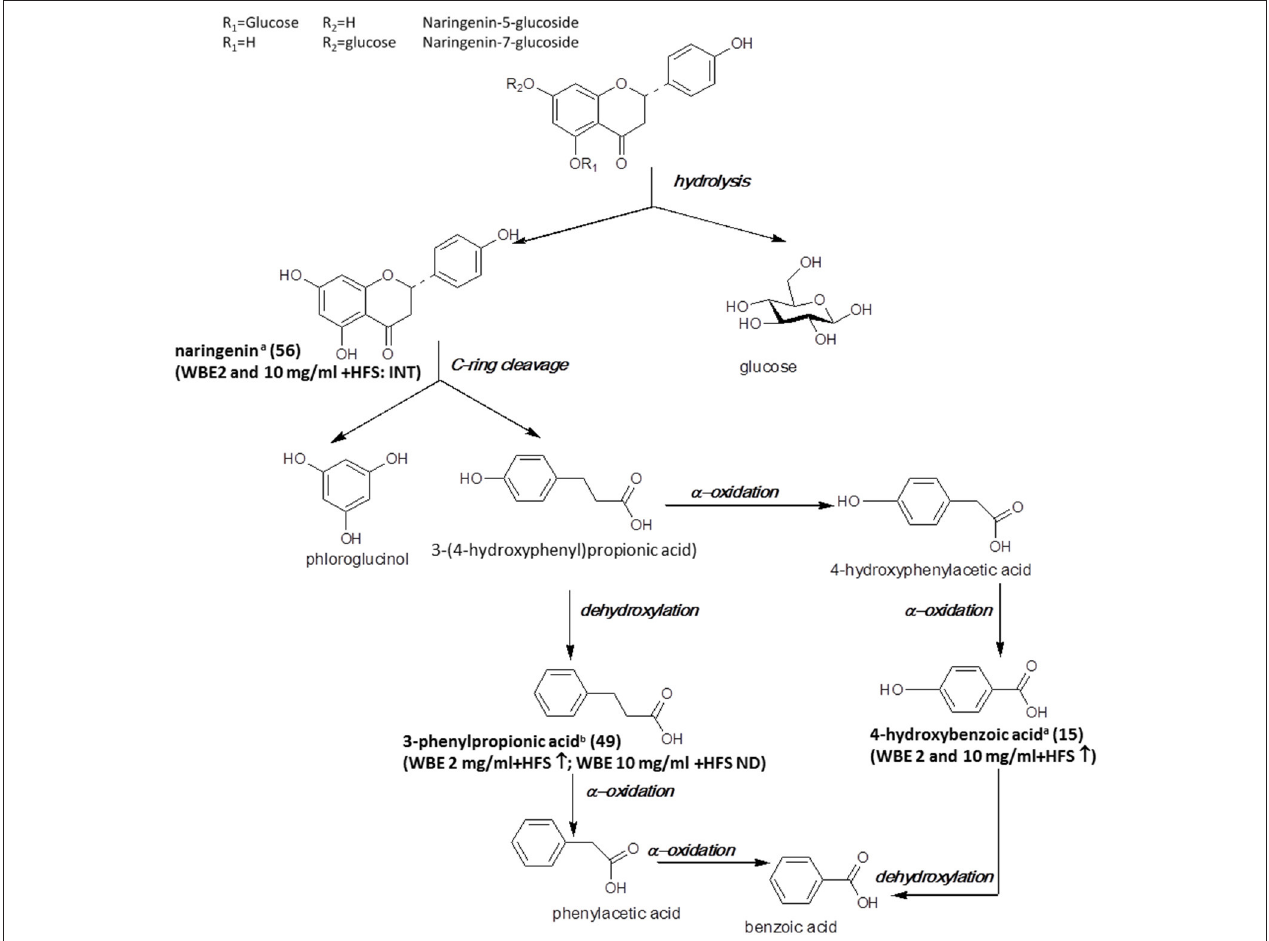
FIGURE 5 | Microbial metabolism of naringenin glycosides as described in the literature (Rechner et al., 2004; Mosele et al., 2015; Orrego-Lagarón et al., 2016). Metabolites detected in the present study are printed in bold (a: identified by comparison with authentic reference compound; b: tentatively identified on basis of HRMS, molecular formula and fragmentation pattern; INT: intermediate; ↑ : significantly increasing over time (ratio t24/t0 > 2, p < 0.05); ↓ : significantly decreasing over time (ratio t24/t0 < 0.5; p < 0.05); ↔ no significant change over time).